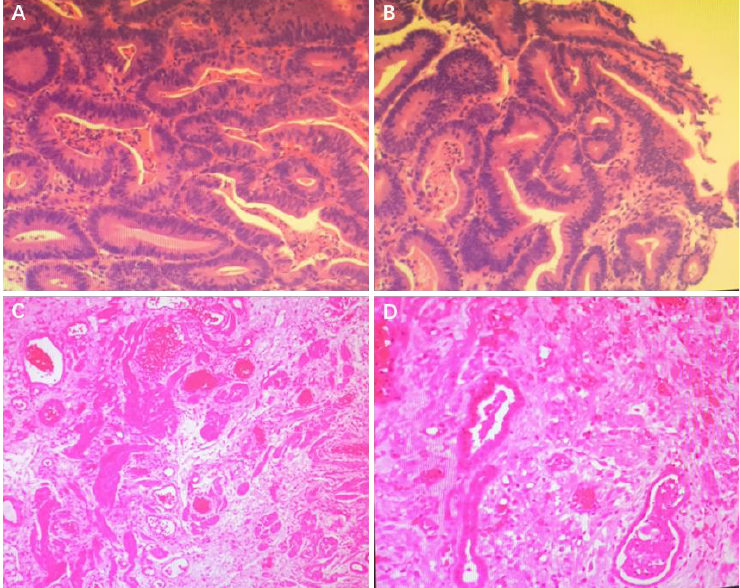
Figure 2. Histopathological findings before and after treatment. The biopsy before treatment turned out to be a highly differentiated adenocarcinoma ( A , B ). A large inflammatory cell infiltration, inter- stitial congestion, hemorrhage, and local fibroplasia could be seen without any malignant evidence after surgery (×40 magnification) ( C , D ).